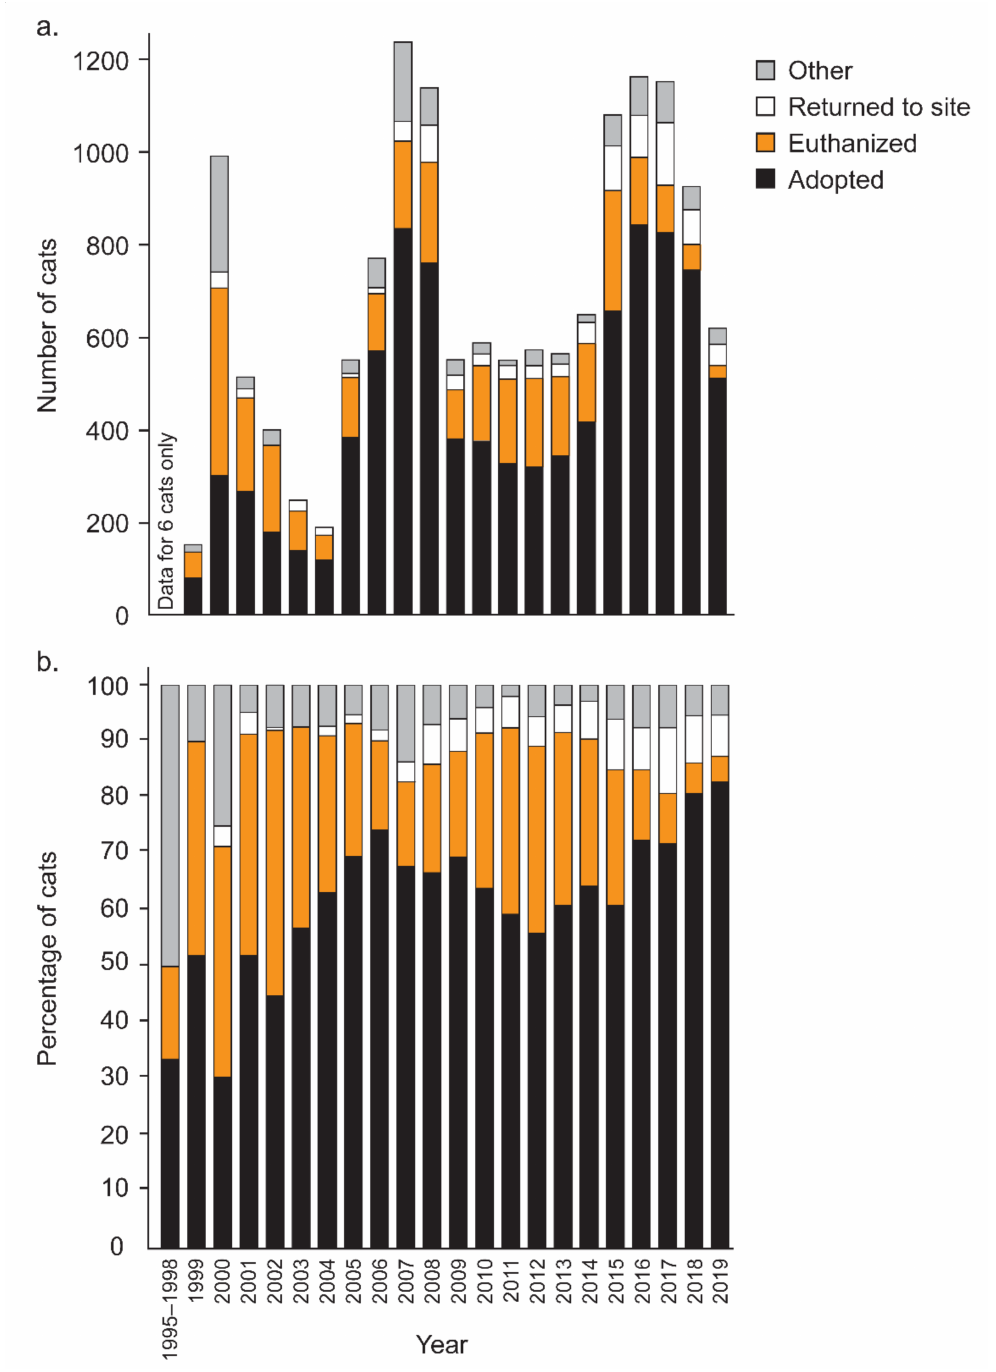
Figure 3. The fate of cats processed for trap–assess–resolve (TAR) through Lonely Miaow, Auckland, New Zealand, between July 1995 and December 2019, showing the breakdown by year. ‘Adopted’ includes adoptions brokered by Lonely Miaow, cats adopted by a foster carer, or cats placed with a pet shop. ‘Other’ includes cats that died, were found dead, escaped, or were transferred to another shelter, and ‘unknown’ where a volunteer had not entered the data. The exact numbers are shown in ( a ) and the percentages in ( b